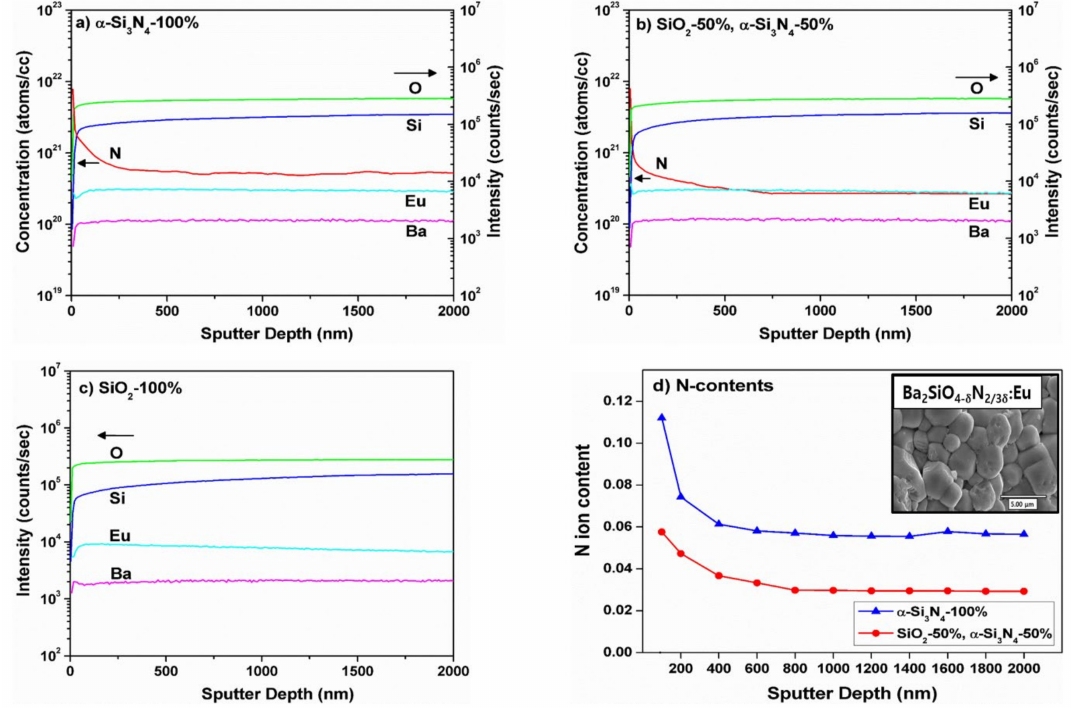
Figure 3. Atomic concentration and intensity as a function of sputtered depth of BSON:Eu 2 + phosphor synthesized using α -Si 3 N 4 -100% ( a ), SiO 2 –50% and α -Si 3 N 4 –50% ( b ), SiO 2 –100% ( c ), and determined N ion contents ( d ) by secondary ion mass spectrometry